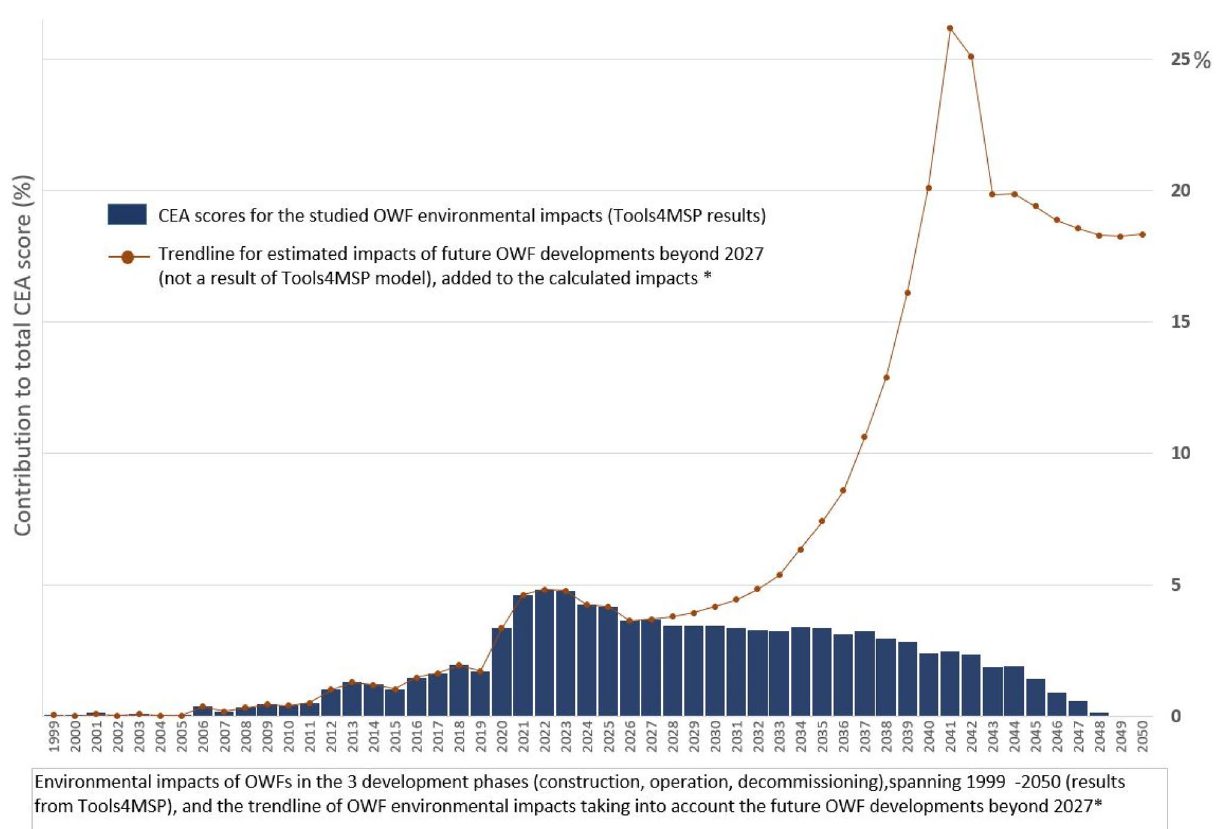
Figure 5. Yearly contribution (%) of OWF phases (construction, operation, decommissioning) to the total CEA score, spanning 1999–2050 (results from Tools4MSP), and the estimated impacts of future developments (beyond 2027, last year of